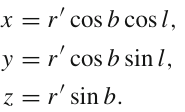
parametersofthetwopossiblemasksconsideredin MadDM